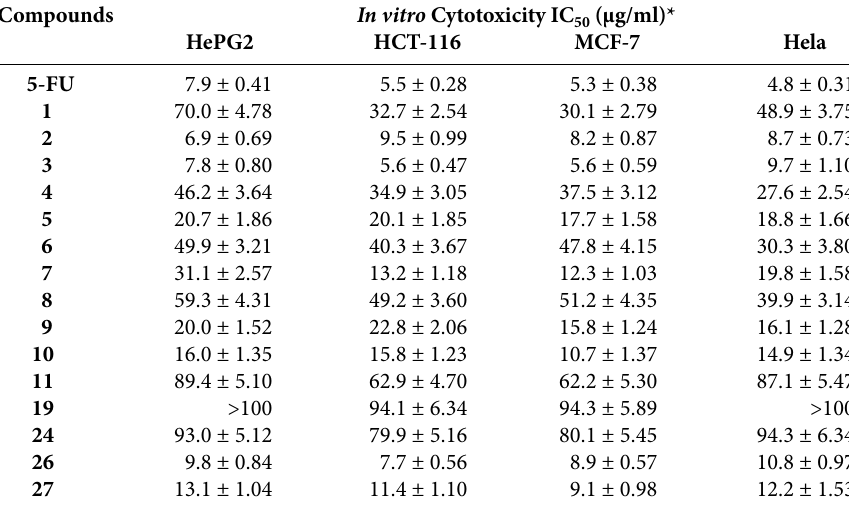
Table 1 . In vitro cytotoxic activity of some new compounds against four cell lines